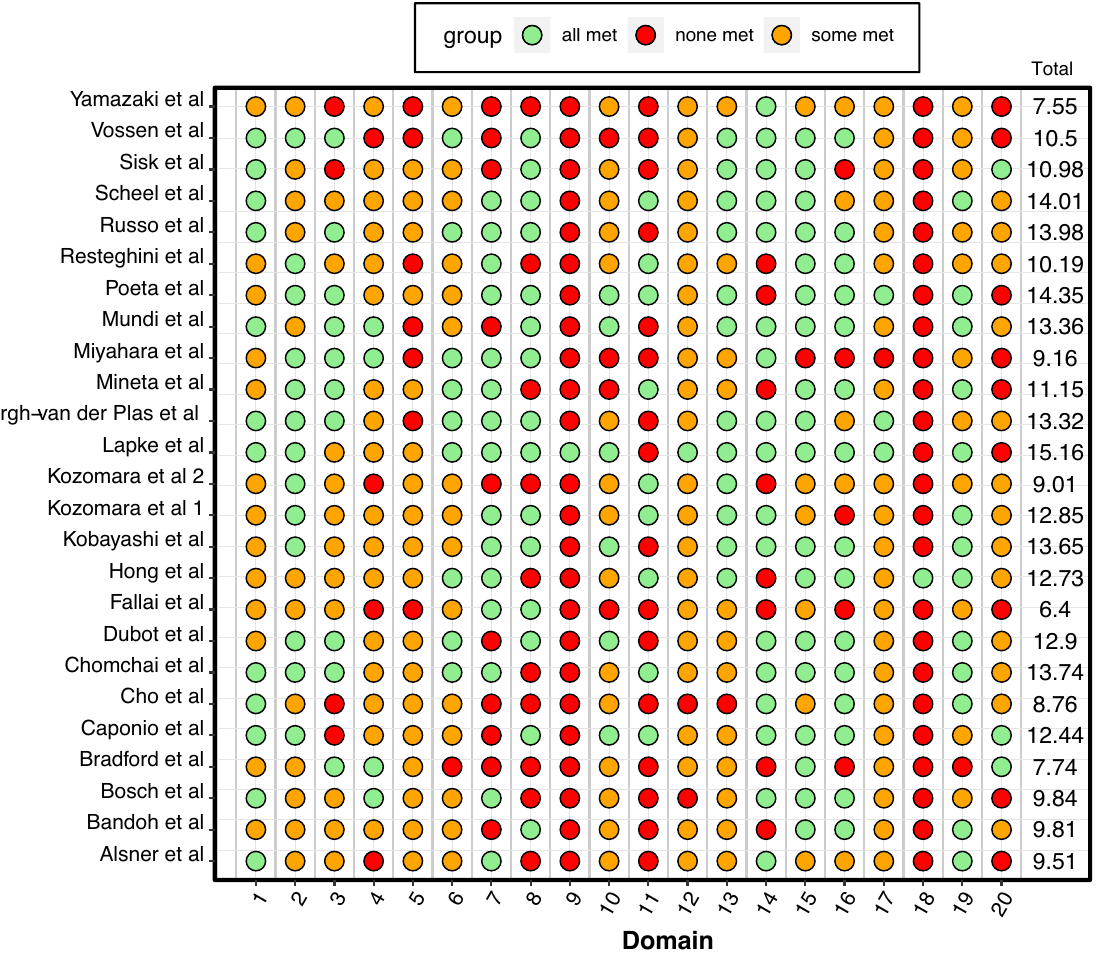
Figure 2. Study fulfilment of the 20-point criteria as set out by the REMARK guidelines 17 . Green indicates the domain was fully met, amber partially met and red none. Total score provided in the rightmost column (maximum score whilst Poeta et al. 31 , in the largest cohort identified in this systematic review (n = 420 patients), identified a significant reduction in overall survival amongst patients with disruptive mutations. Lindenbergh-van der Plas et al. 26 similarly used the classification of Poeta et al. 31 classifying according to the involvement of the p53 DNA- binding domain, and additionally assessed the role of mutation type, namely truncation or missense. Affirming Poeta’s findings, this study identified significantly worse overall survival in the presence of a disruptive mutation, and found that truncating mutations (but not missense) were associated with poorer outcomes on multivariate analysis. In a modest-sized cohort, restricted to oral SCC patients, Yamazaki et al. 28 showed that mutations in conserved regions of TP53 or within DNA-binding motifs exhibited poorer survival than cases with other p53 mutations. Similarly, the presence of mutations within DNA-binding regions of p53 were strongly associated with locoregional failure, nodal metastasis and distance metastasis. TP53 mutations of exon 5–8, which encode a region important in stabilisation of the protein tertiary structure and the DNA-binding domain, have also been associated with lower survival rates in laryngeal SCC. Russo et al. 30 in a cohort of 81 stage III and IV laryngeal SCC, found that mutations in exon 5 were an independent prognostic factor for both disease-free survival and overall survival, and that exon 8 mutations were independently associated with overall survival but importantly not relapse.